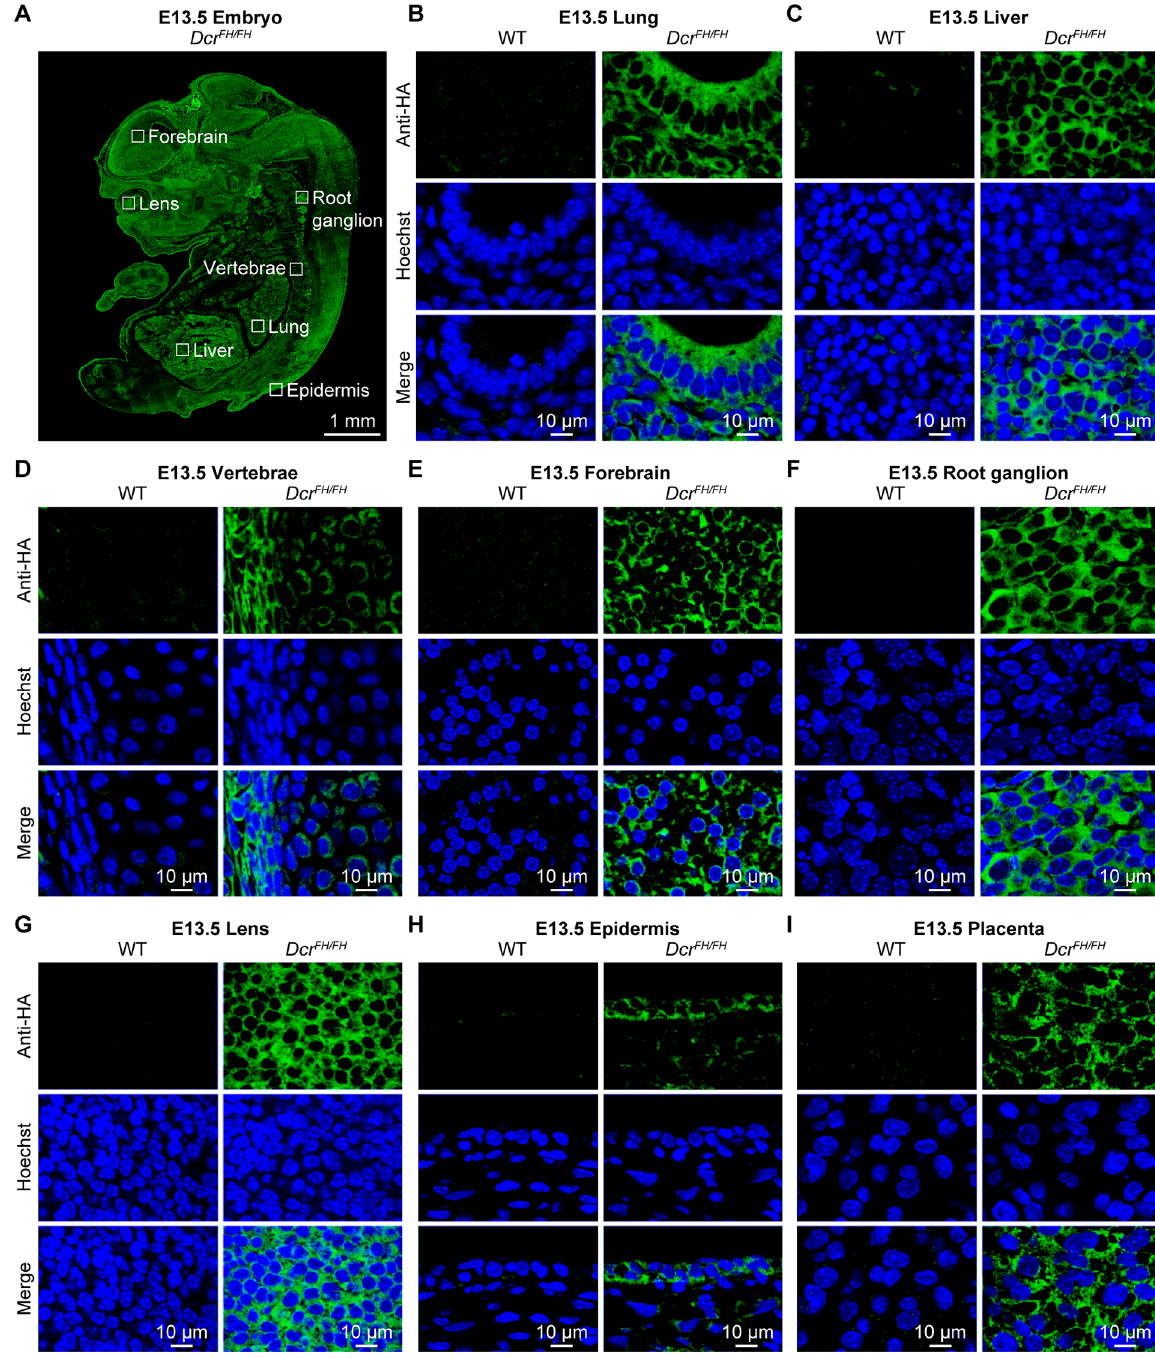
Fig 5. Dicer is solely cytoplasmic during embryogenesis. (A) Anti-HA immunofluorescence of E13.5 Dcr FH/FH embryo section. Scale bar is 1 mm. (B-I) Confocal microscopy of immunofluorescence staining of wild type and Dcr FH/FH E13.5 tissue sections with anti-HA antibody. Sections of lung (B) and liver (C) are shown as representatives of endoderm, vertebrae (D) represent mesoderm, forebrain (E), root ganglion (F), lens (G) and epidermis (H) represent ectoderm, placenta (I) is depicted as an example for an extraembryonic tissue. Nuclei are stained with Hoechst. Scale bar is 10 μ